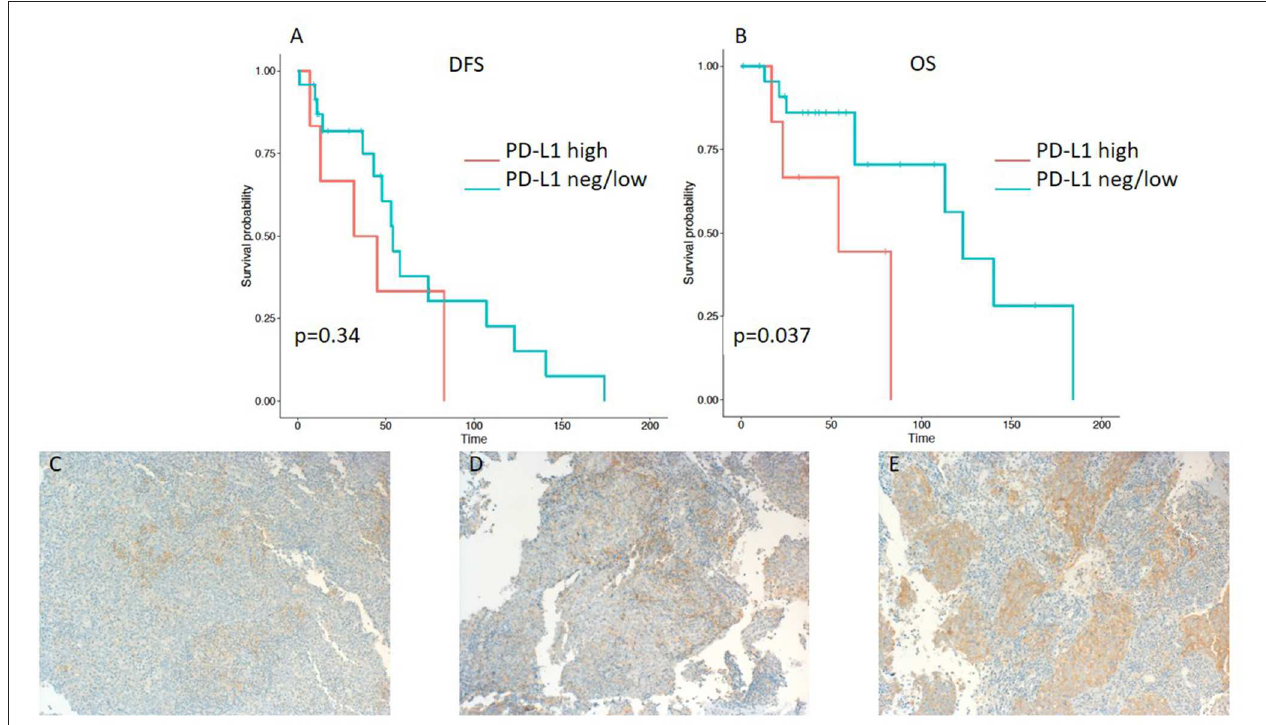
FIGURE 1 | Kaplan–Meier curves for DFS (A) and OS (B) according to PD-L1 expression on tumor cells (TC) (neg/low vs. high). Representative images of PD-L1 expression on TC: (C) negative, (D) low, and (E) high (x100 magnification). PD-L1, programmed death ligand 1. Log-rank tests were performed, and p -values are